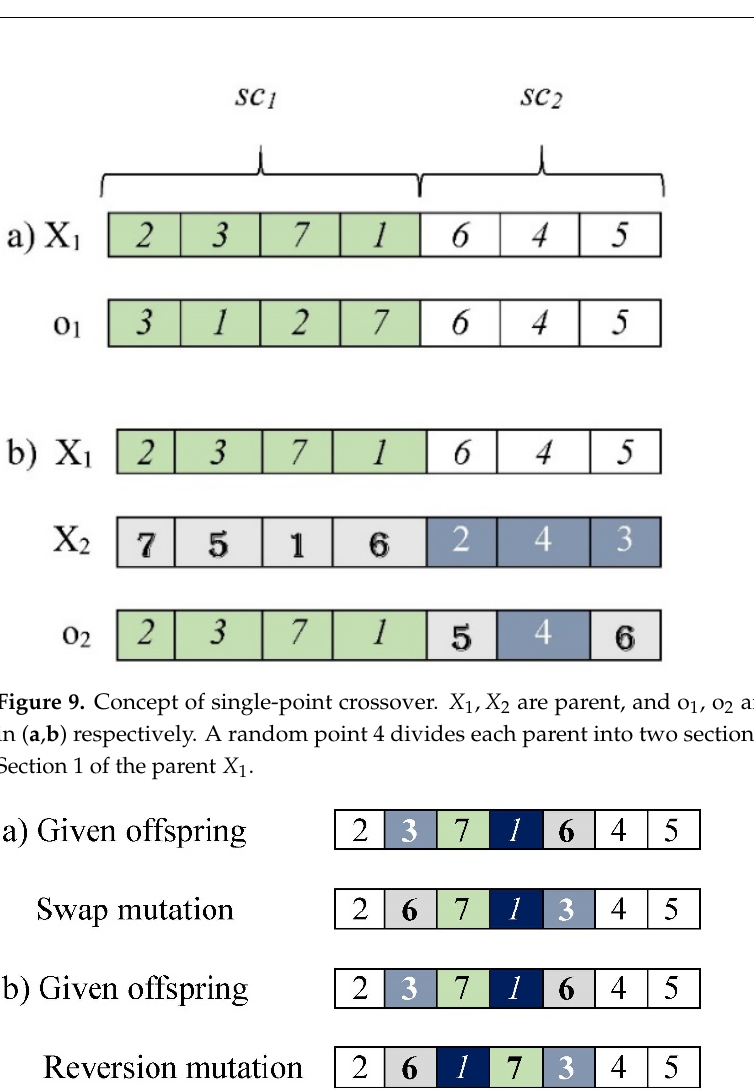
Figure 10. ( a ) Swap mutation and ( b ) reversion mutation for the same solution with two random points, 2 and 5. Table 2. Parameter settings for NSGA-II.